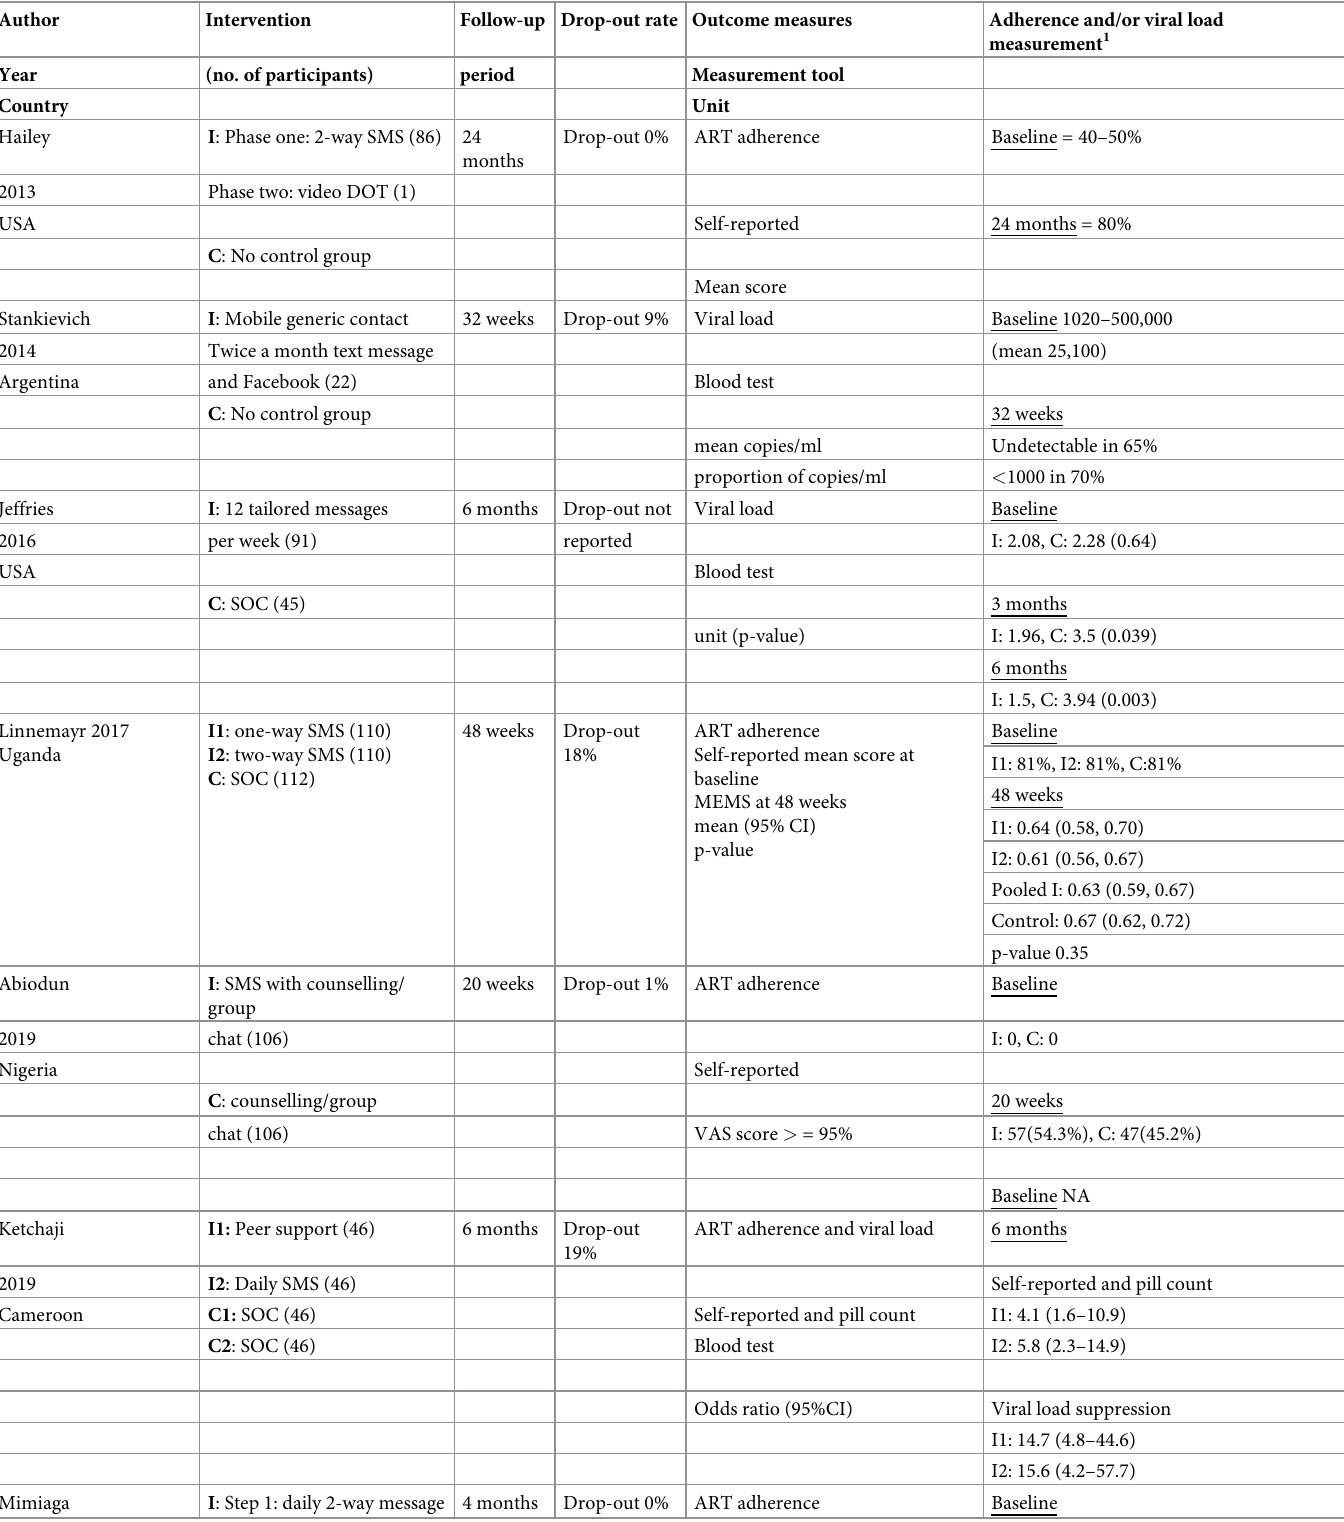
Table 2. Reviewed